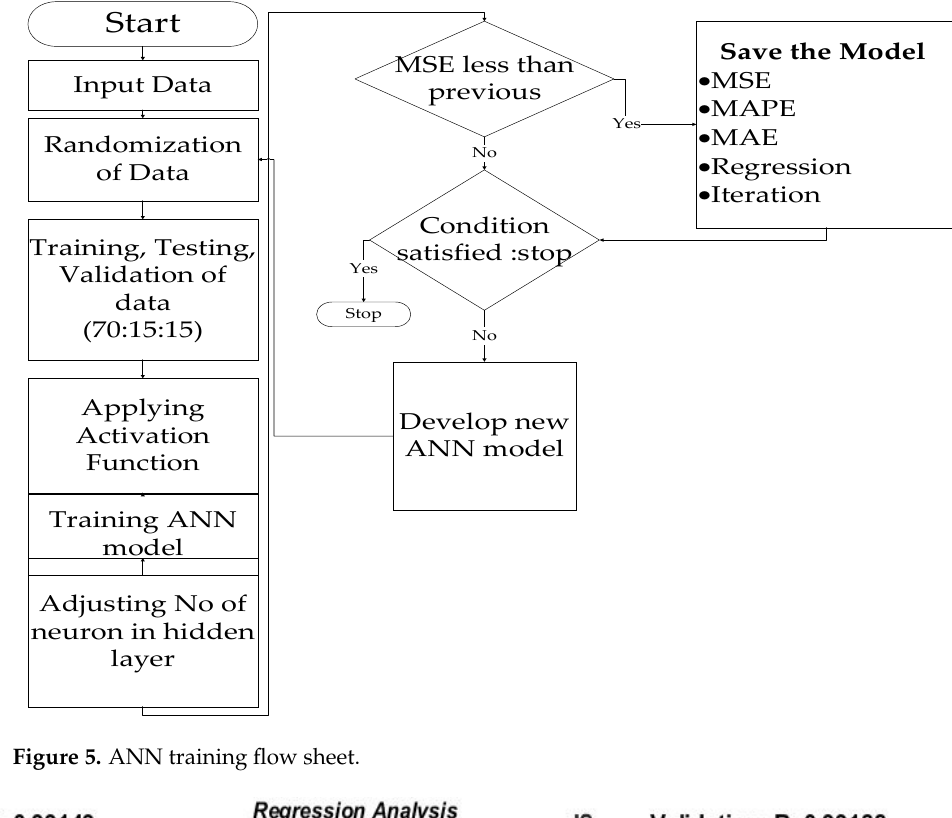
Figure 4. Structure of MISO Layer of Artificial Neural Network.